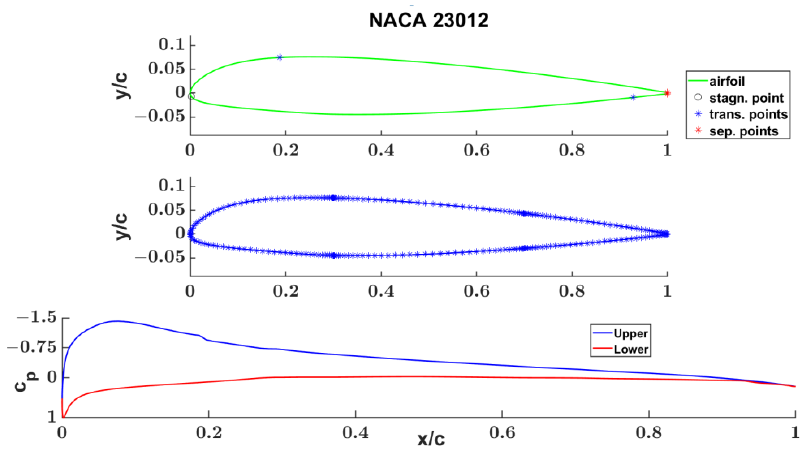
Figure 26. NACA 23012 airfoil — segment Chebyshev discretization — Cp(x) at Re 3.5 × 10 6 , alfa 4°. Figure 27 represents the normal and tangent vectors to the airfoil and their decom- position in the V inf direction, and the one normal to it; the pressure forces, their segment- wise distribution, and decomposition along the V inf direction, and the normal to it. The normal and tangent vectors and the curvilinear abscissa were used for the calculation of the pressure forces.